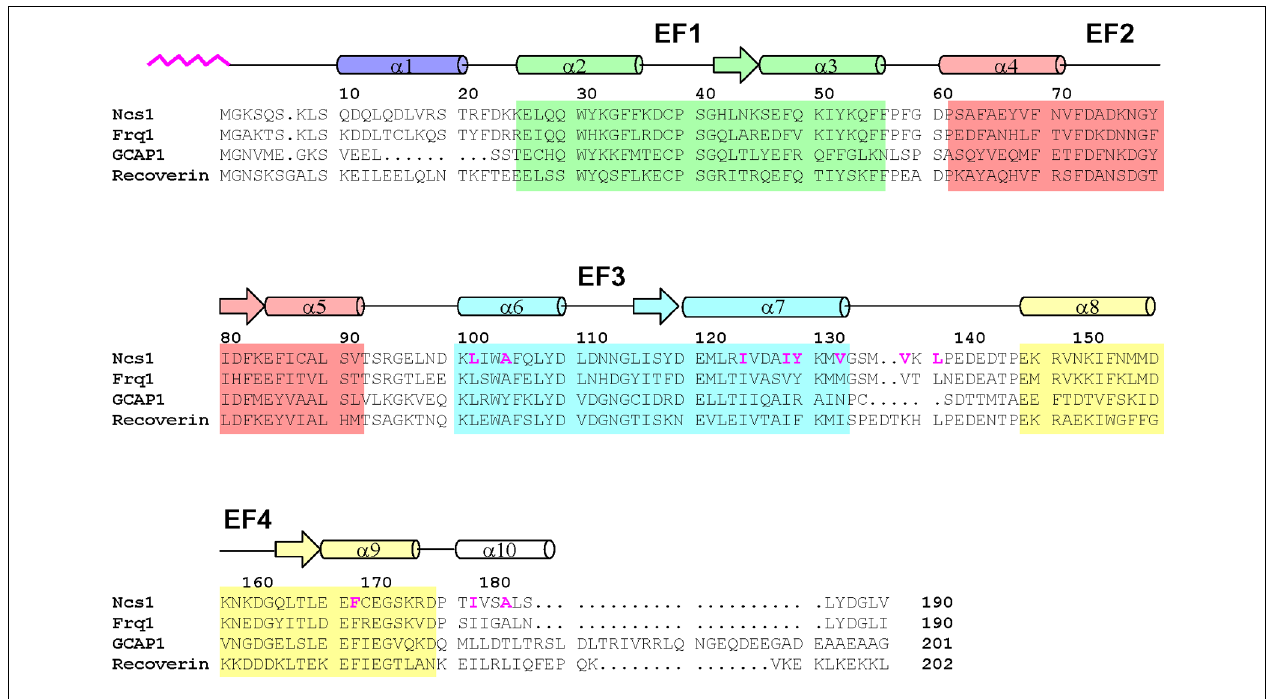
FIGURE 1 |Amino acid sequence alignment of selected NCS proteins (sequence numbering is for S. pombe NCS-1). Secondary structure elements (helices and strands), EF-hand motifs (EF1 green, EF2 red, EF3 cyan, and EF4 yellow), and residues that interact with the myristoyl